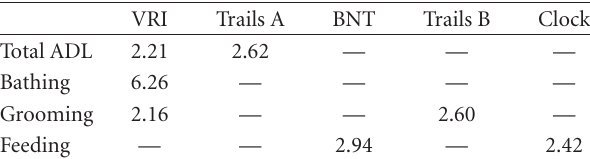
Table 5: t values of predictors of ADLs in men.